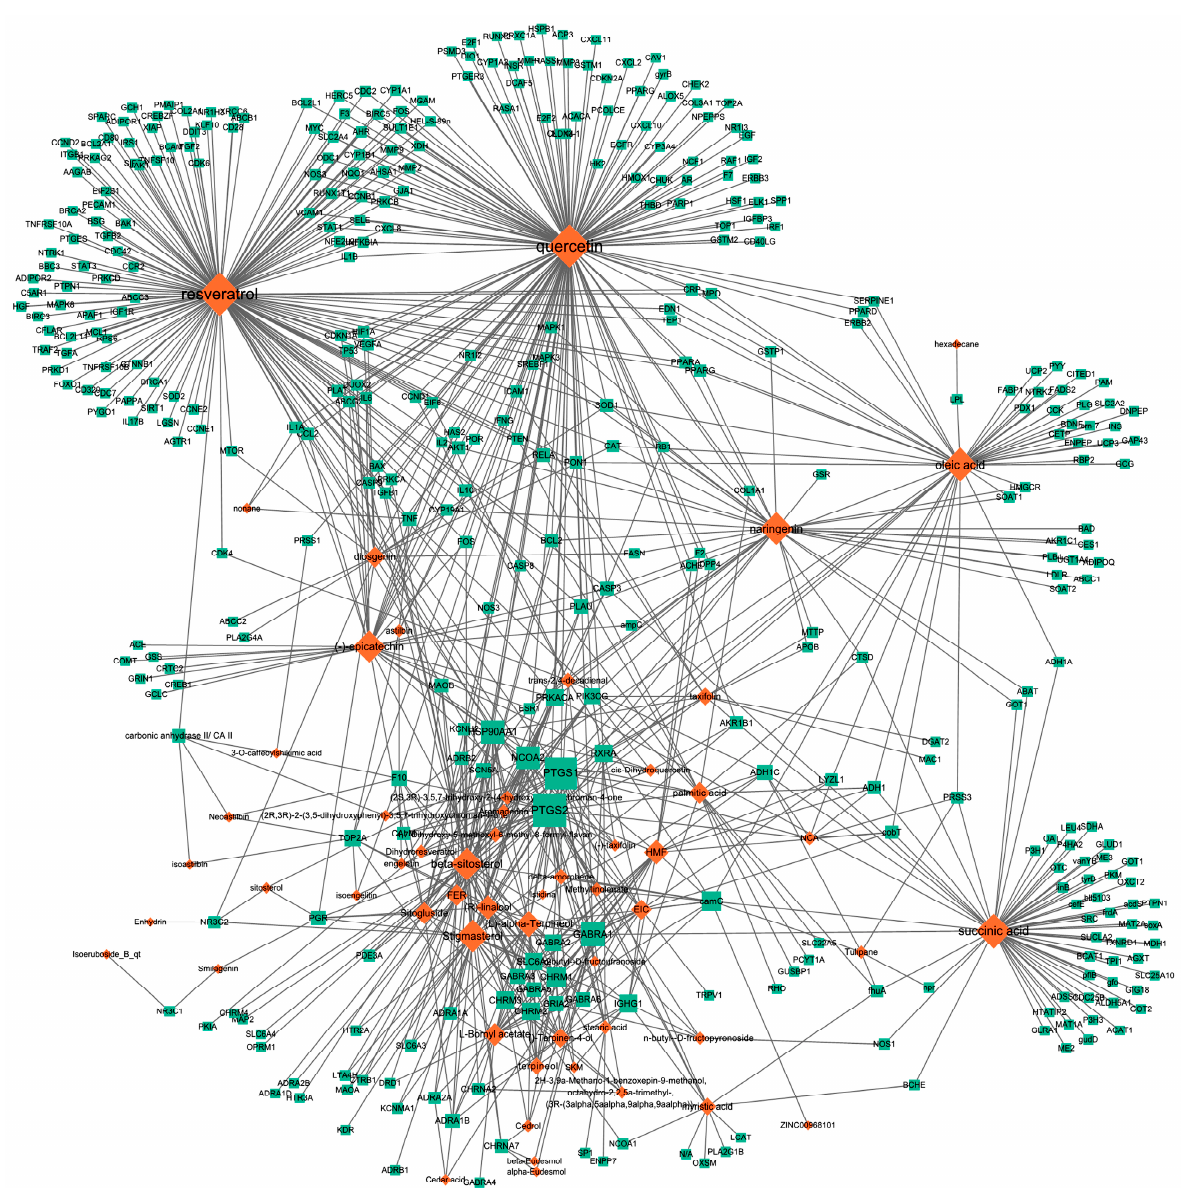
Figure 2. Compound–target network of SGR. The node size depends on the connected edges’ number. The compounds are expressed as orange diamond-shaped nodes, and the targets are expressed as green square-shaped nodes. SGR: Smilacis Glabrae Rhixoma.